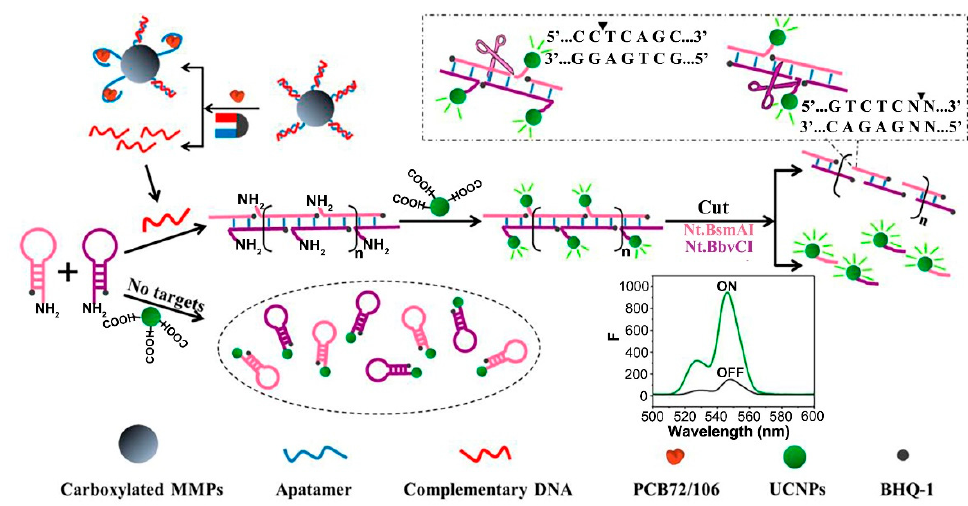
Figure 4. Schematic illustration of the dual-amplification strategy for PCB72/106 detection of upcon- version fluorescent aptasensor based on HCR and nicking endonuclease. Reprinted with permission from [102]. Copyright 2018, American Chemical Society.